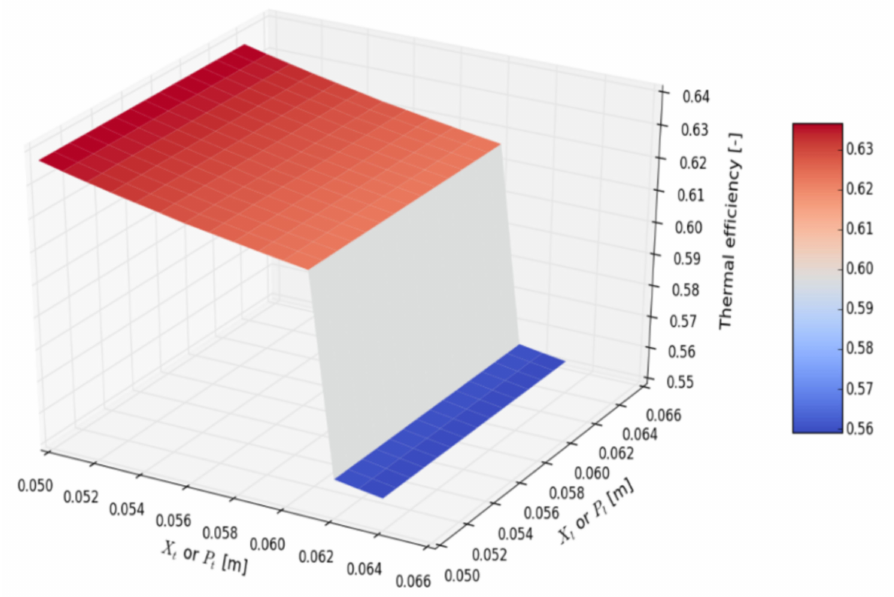
Figure 17. Thermal efficiency vs. traversal and longitudinal spacing of the tubes. The hot air heat transfer coefficient grows by 20% with traversal spacing